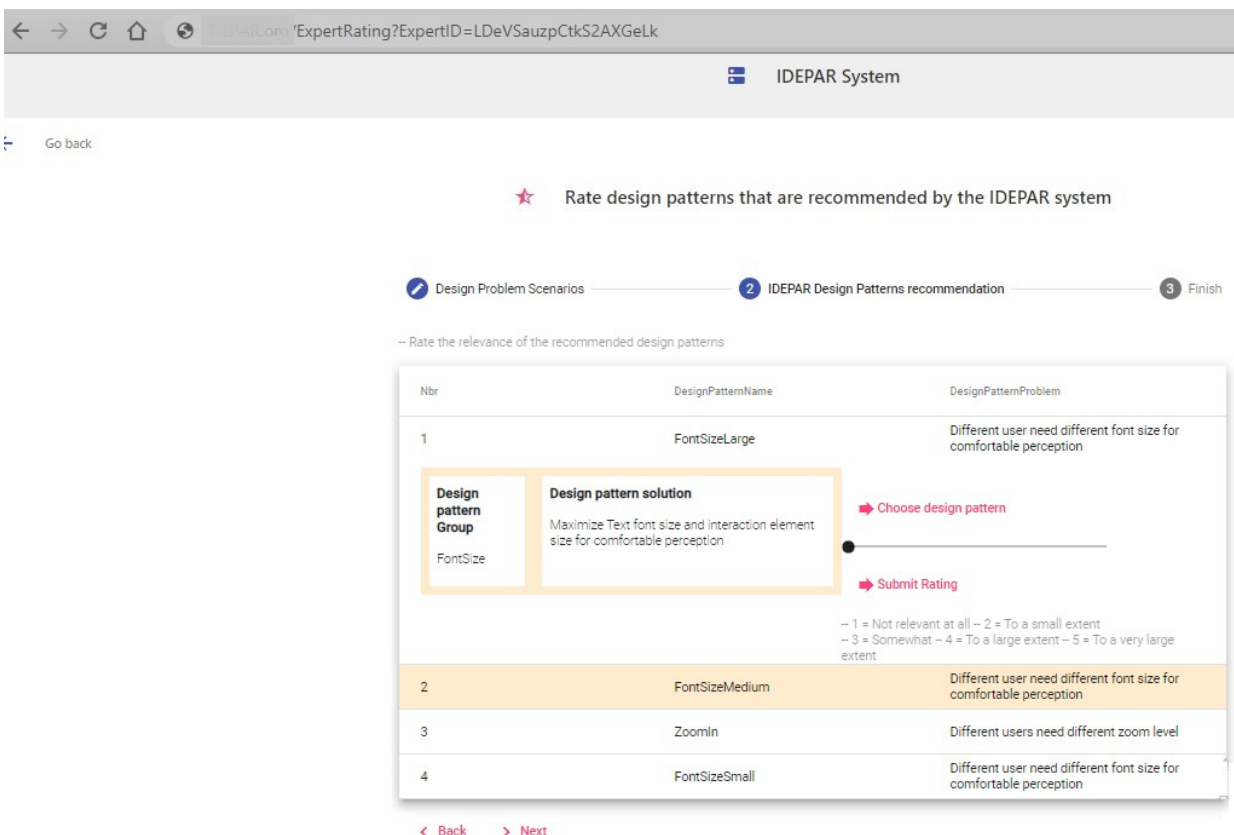
Figure 17. List of recommended design patterns for DPS-2.